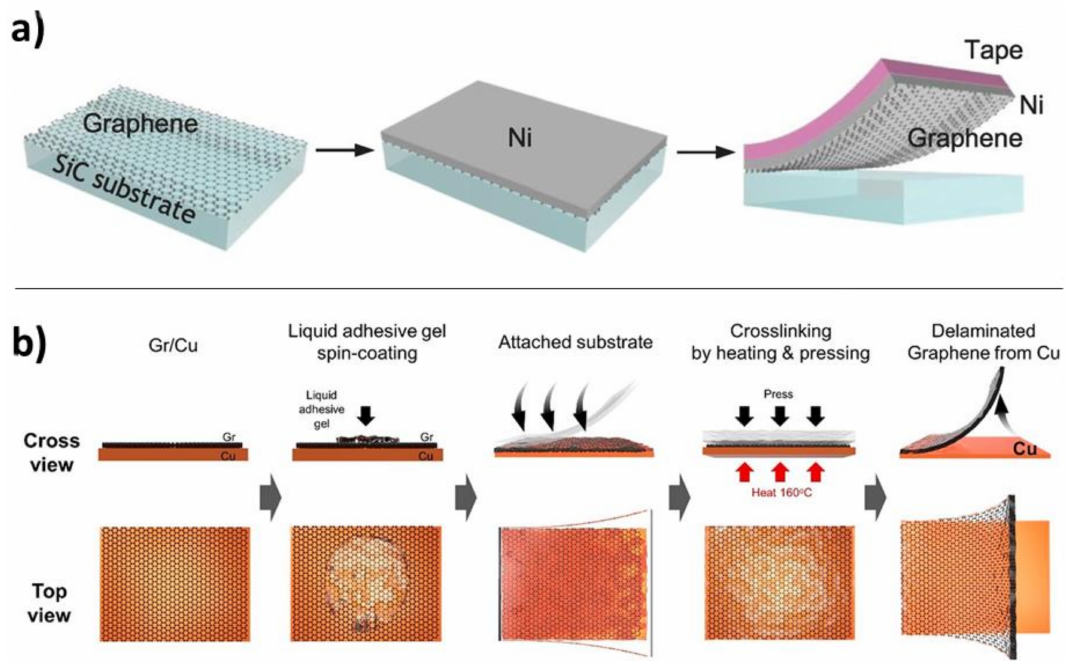
Figure 8. Examples of mechanical methods for facilitating delamination of graphene. ( a ) Nickel sputtering onto epitaxial graphene grown on SiC, followed by mechanical exfoliation of graphene. The nickel substrate adheres the graphene more strongly than the original SiC growth substrate. Adapted with permission from Ref. [8]. Copyright 2013 American Association for the Advancement of Science. ( b ) Liquid-phase adhesive-assisted delamination of graphene from an original copper growth substrate. The liquid gel is highly conformal to the graphene, augmenting its adhesive energy above that of the copper and allowing subsequent mechanical delamination. Adapted with permission from Ref. [80]. Copyright 2021 American Chemical